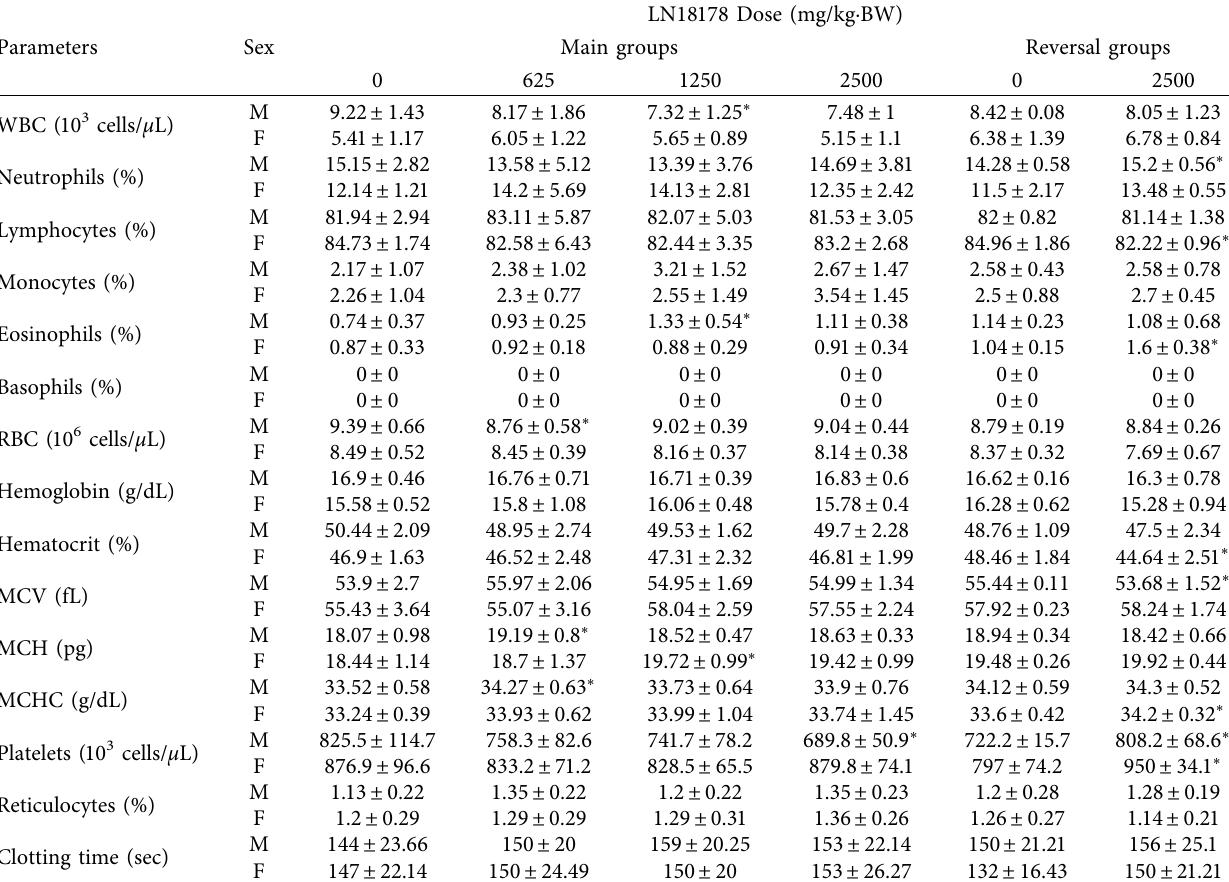
Table 3: Effect of oral administration of LN18178 on blood parameters in male and female Wistar